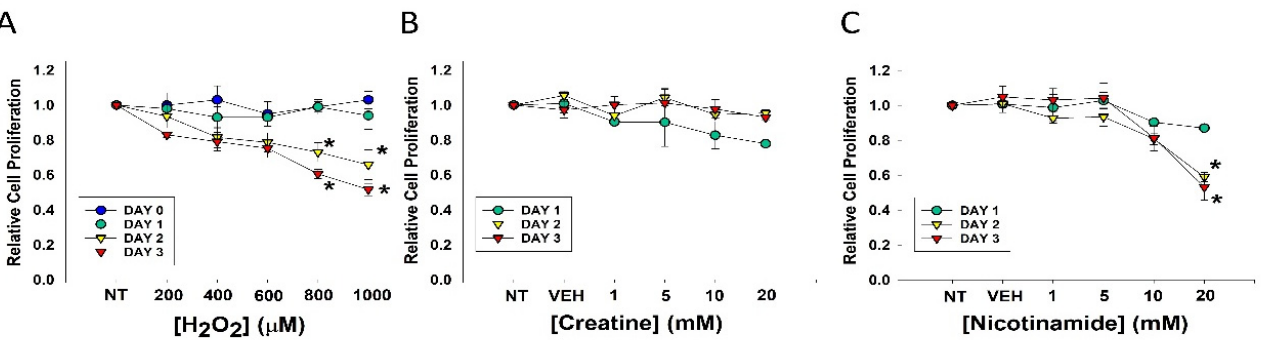
Figure 1. Effects of varying concentrations of agents on fibroblast cell proliferation. DHF were treated with various concentrations of ( A ) H 2 O 2 ; ( B ) Cr; ( C ) NAM, water (1%) vehicle, or no treatment (sham; NT) and MTT assays performed at days 1, 2, or 3 to assess cellular viability. The data are mean ± SE of triplicate experiments. * Statistically significant ( p < 0.05) decreased relative cell proliferation was found on days 2 and 3 of 800 µM and 1 mM H 2 O 2 treatment, as well as 20 mM NAM at days 2 and 3.